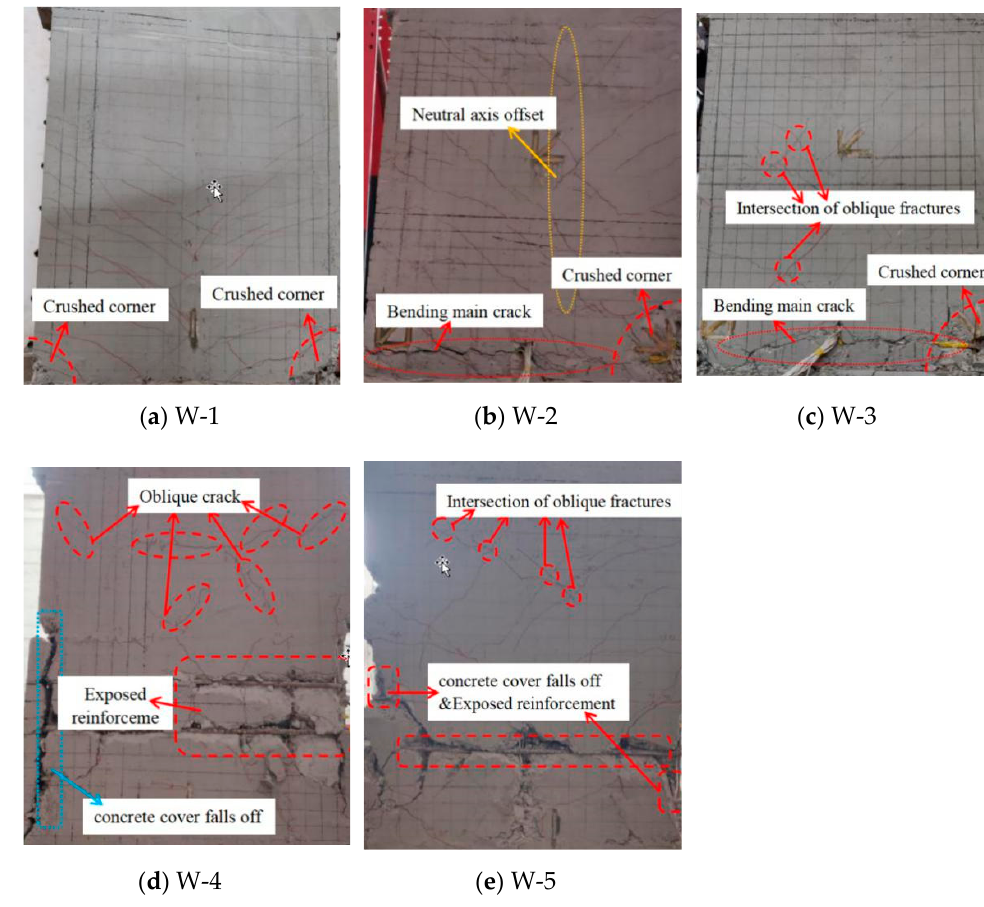
Figure 7. Failure characteristic diagram of composite wallboard.